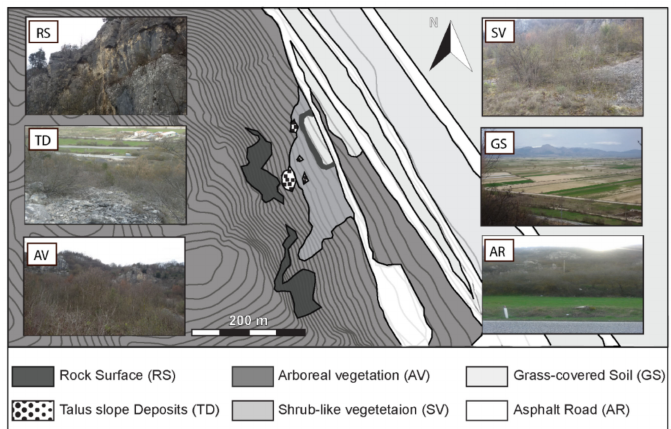
Figure 6. Slope terrain